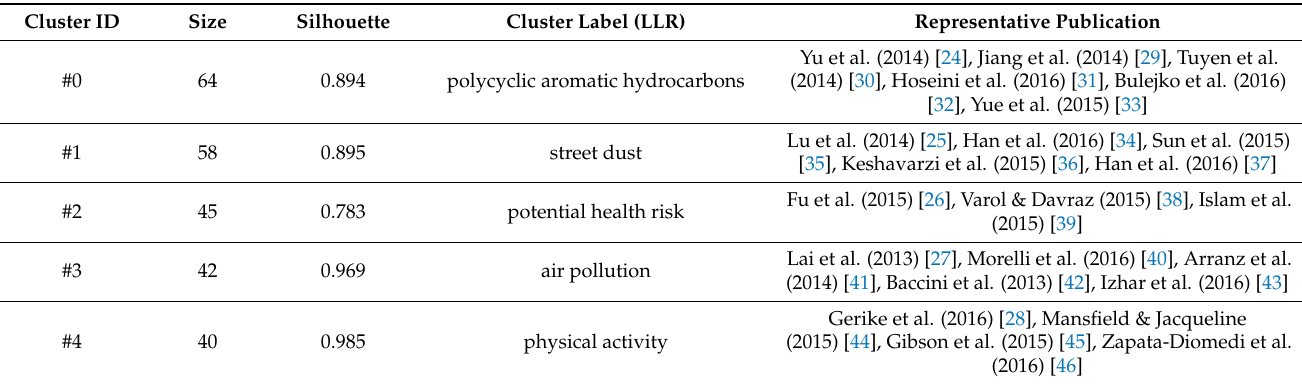
Table 5. Summary of the largest five clusters in 2012–2016.